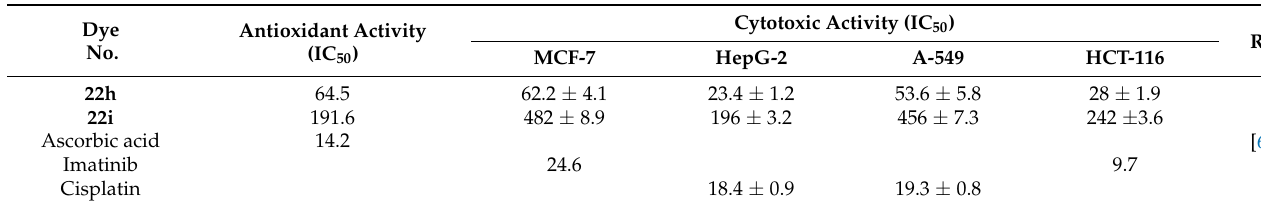
Table 4. Antitumor and antioxidant activities of disperse dyes 22h and 22i.